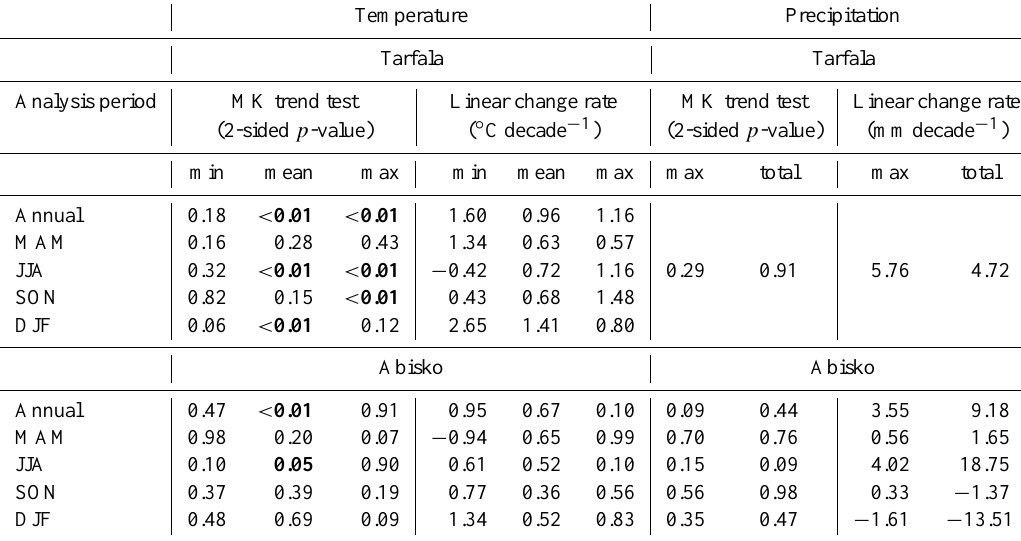
Table 2. Summary of the Mann-Kendall (MK) trend test statistics of annual and seasonal temperature and precipitation trends for the common time period of 1985–2009 for the Tarfala and Abisko catchments. Trend significance of the MK trend test is indicated by the 2-sided p -value and trends significant at the 5% level are highlighted in bold. Linear change rates and the type of change (i.e., increasing (positive values), decreasing (negative values)) were estimated from the slope of a linear regression fitted to the data. Temperature Precipitation Tarfala Tarfala Analysis period MK trend test Linear change